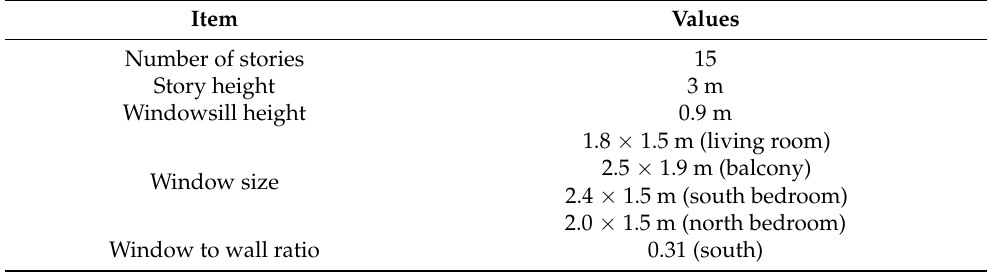
Figure 2. Layout and section of the case study building (the unoccupied flat selected for measurement is denoted by the orange box whilst the other flats are in normal use; the orientation of the building is shown in the top right corner). Table 2. Details of the case study building.